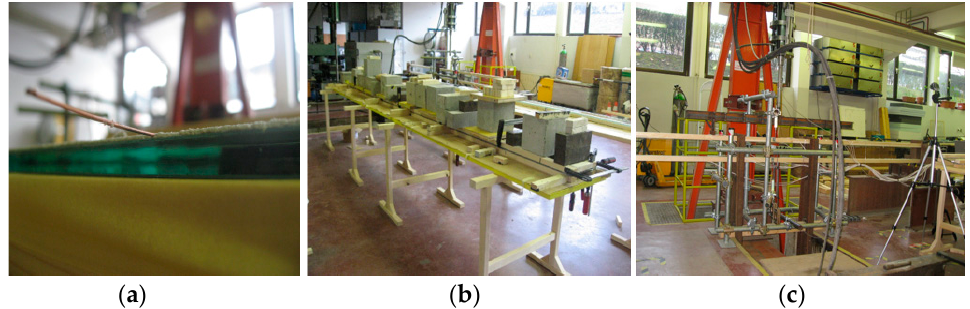
Figure 14. ( a ) wire spacer to secure the correct thickness of epoxy adhesive; ( b ) weighting of the already bonded TGIB; ( c ) TGIB with epoxy adhesive during testing.